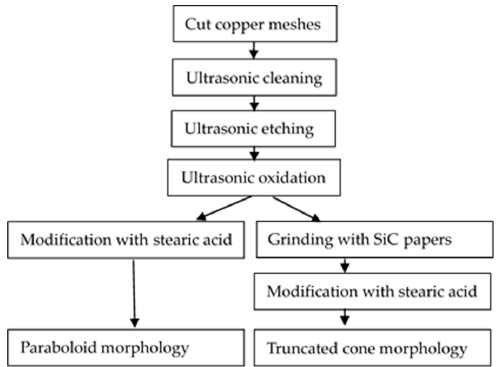
Figure 1. Preparation process schematic diagram of the two morphologies.